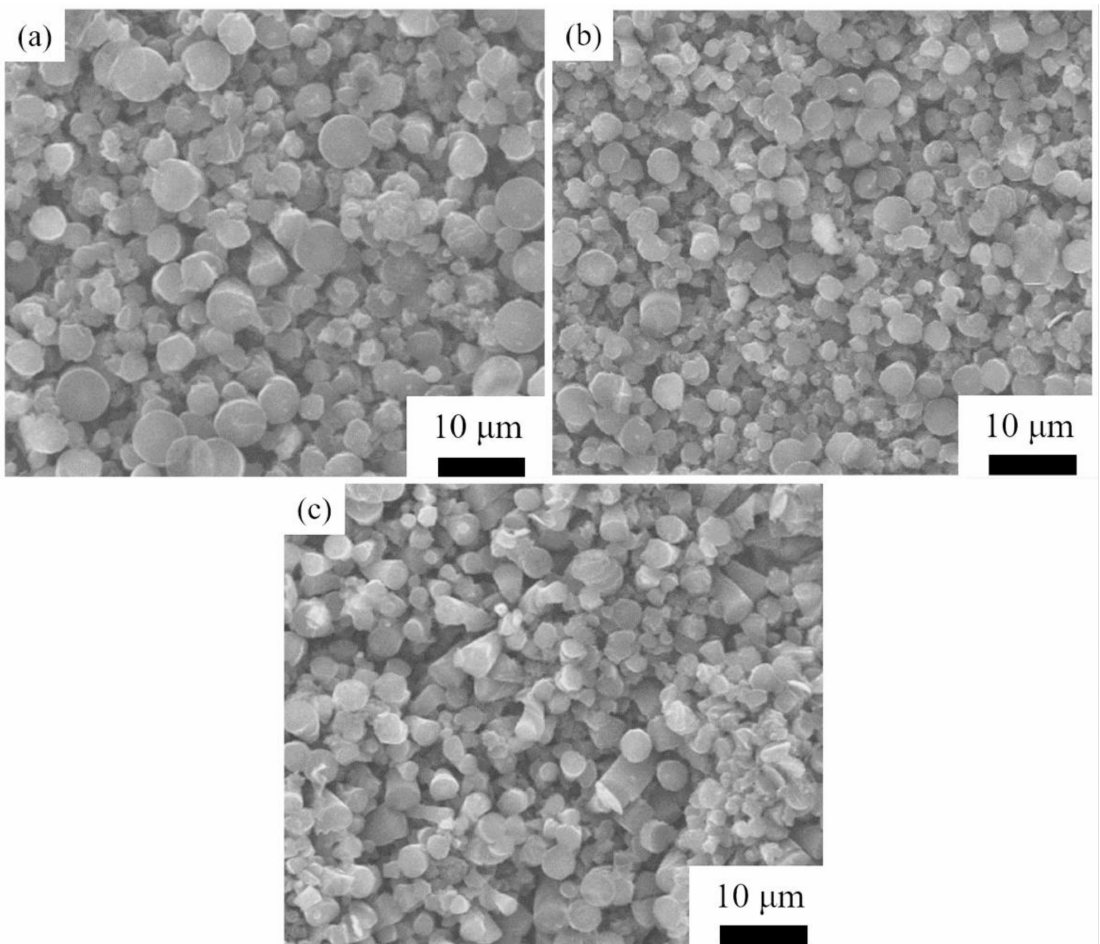
Figure 5. The morphology of SiC grains prepared by HTPVT at 2100 ◦ C for 10 min: ( a ) 2000 Pa; ( b ) 3000 Pa; ( c ) 4000